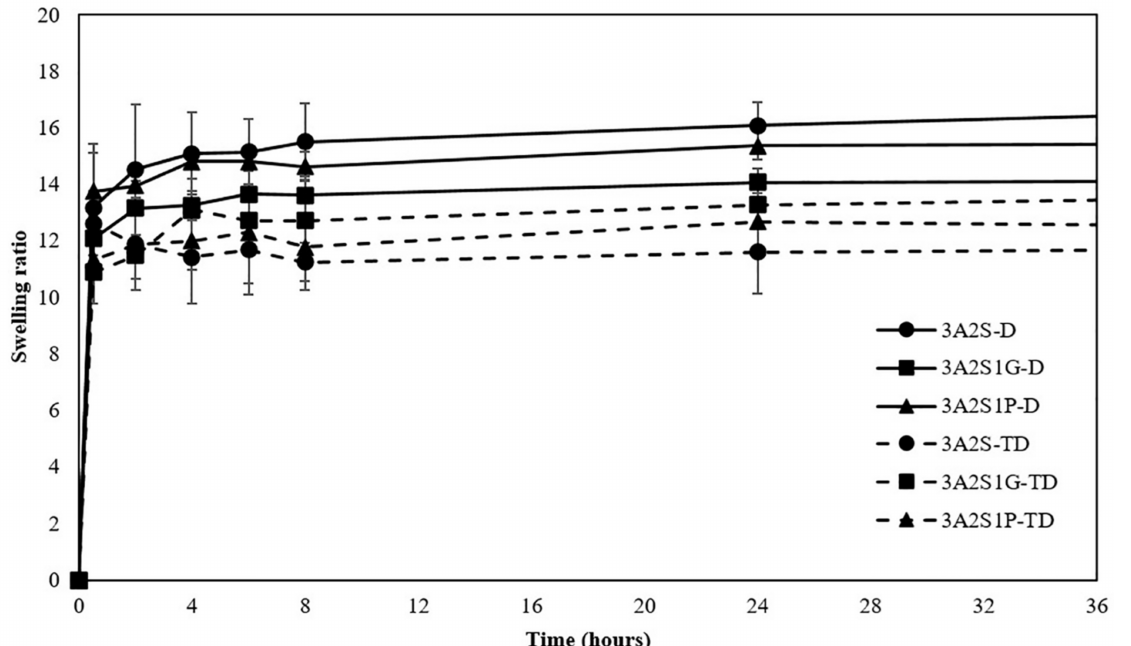
Figure 2. Swelling ratio of scaffolds (3A2S, 3A2S1G, 3A2S1P) that were prepared by the freeze-drying method (D) (solid line) and by freeze-thawing together with the freeze-drying method (TD) (dashed line).